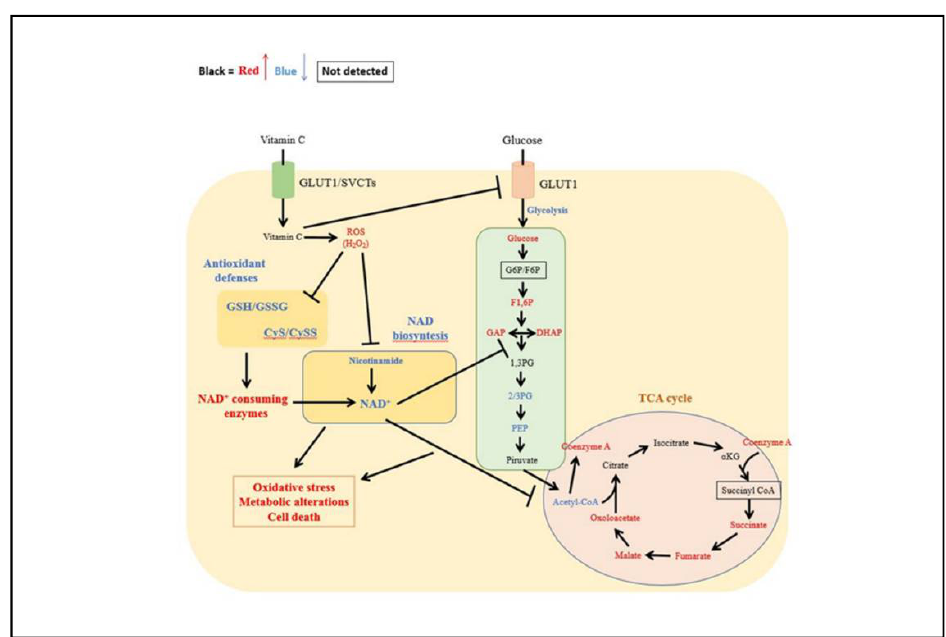
Figure 7. Summary of the effect of a high dose of vitamin C in B-CPAP and K1 cells. Vitamin C induces oxidative stress by increasing ROS and therefore decreasing antioxidants. The decrease of GSH and CyS results in deregulation of the NAD + biosynthesis and consequently in an impairment of energetic pathways, such as glycolysis and TCA cycle. Color coding indicates significantly different metabolites (red, upregulated; blue, downregulated; black, unchanged; boxed, not de- tected).